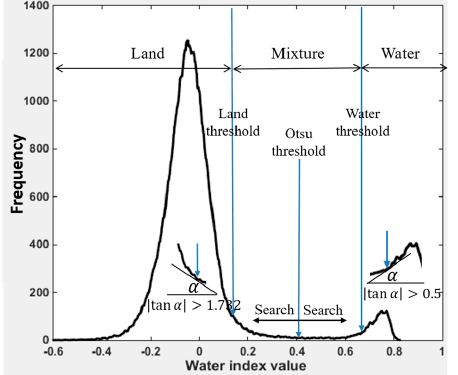
Figure 3. Histogram of the NDWI at the Shanghai test site.